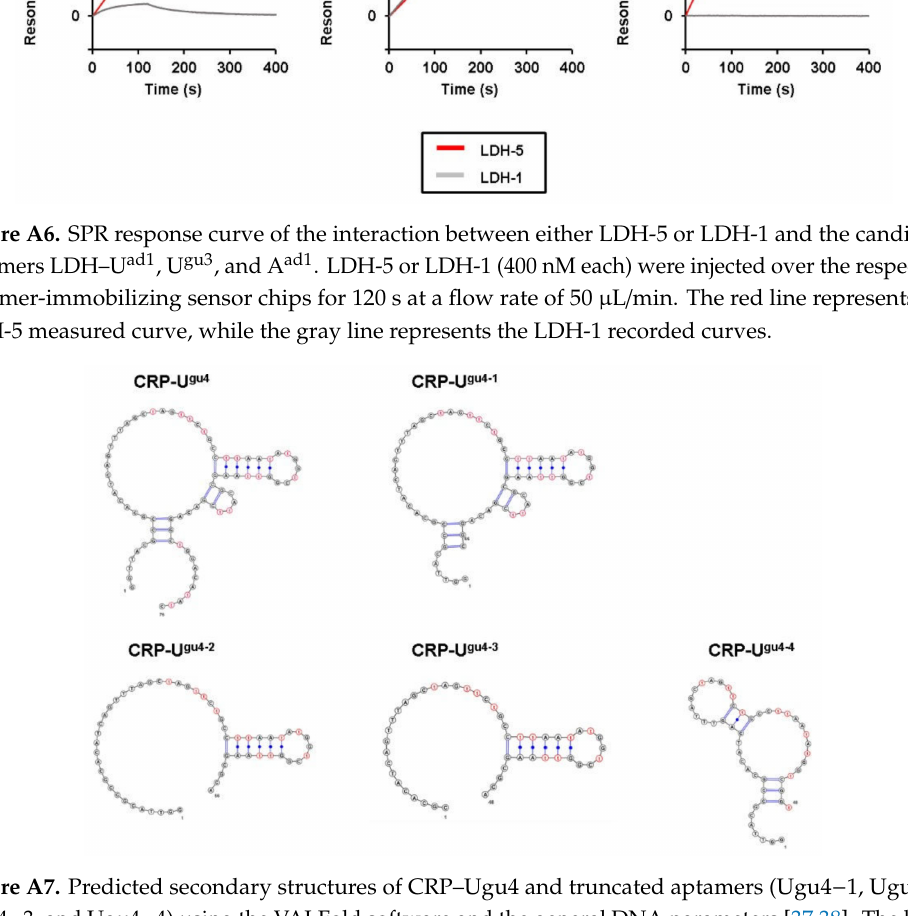
Figure A7. Predicted secondary structures of CRP–Ugu4 and truncated aptamers (Ugu4 − 1, Ugu4 − 2, Ugu4 − 3, and Ugu4 − 4) using the VALFold software and the general DNA parameters [37,38]. The letter “t” indicates